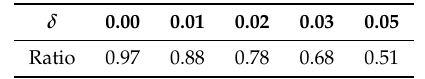
Table 5. Ratios between prices with and without dependence.